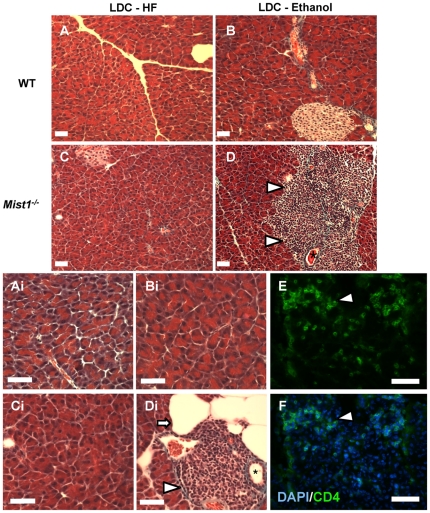

Mist1−/− pancreata develop periductal accumulations of inflammatory cells in response to ethanol feeding.Representative photomicrographs of Gomori's trichrome stained pancreatic sections from WT (A, B) and Mist1−/− mice (C, D) fed a LDC-HF (A, C) or LDC-E (B, D) diet for 6 weeks. Higher magnification images from the same sections (Ai–Di) were used to highlight specific morphological events. Cellular accumulations (arrowhead) surrounding ducts (*) and adipose accumulations (arrow) were observed only in LDC-E fed Mist1−/− mice. (E, F) Immunofluorescent analysis for the T-lymphocyte marker CD4 (E) indicated that these accumulations consisted of lymphocytes (arrowhead). Sections were co-stained with DAPI (F) to reveal all cells. Magnification bars = 40 µm.